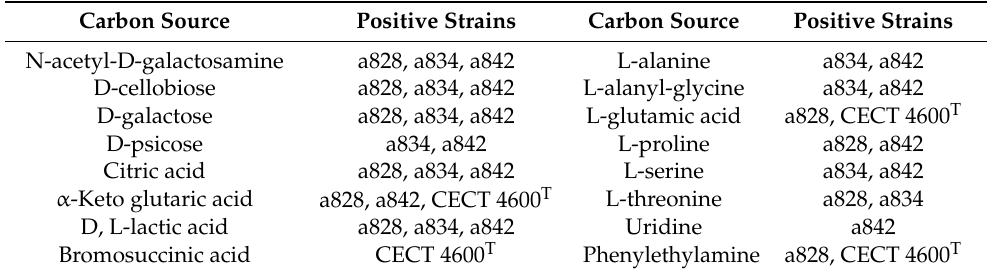
Table 1. Differences in carbon compound utilization between the V. tapetis meager isolates a828, a834 and a842, and V. tapetis CECT 4600 T , determined using the BIOLOG GN system. Carbon Source Positive Strains Carbon Source Positive Strains N-acetyl-D-galactosamine a828, a834, a842